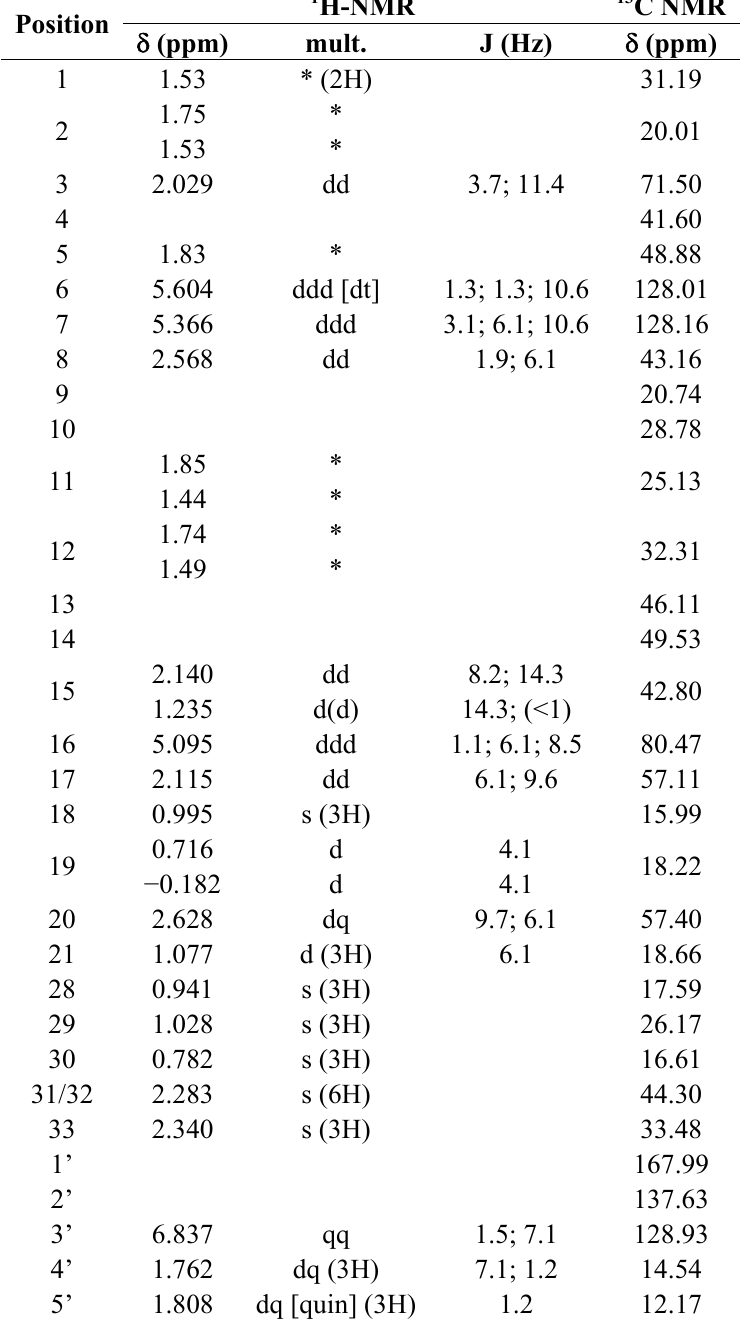
Table 2. NMR data of O -tigloylcyclovirobuxeine-B ( 1 ) in CDCl confirmed by 1 H/ 13 C-HSQC and -HMBC